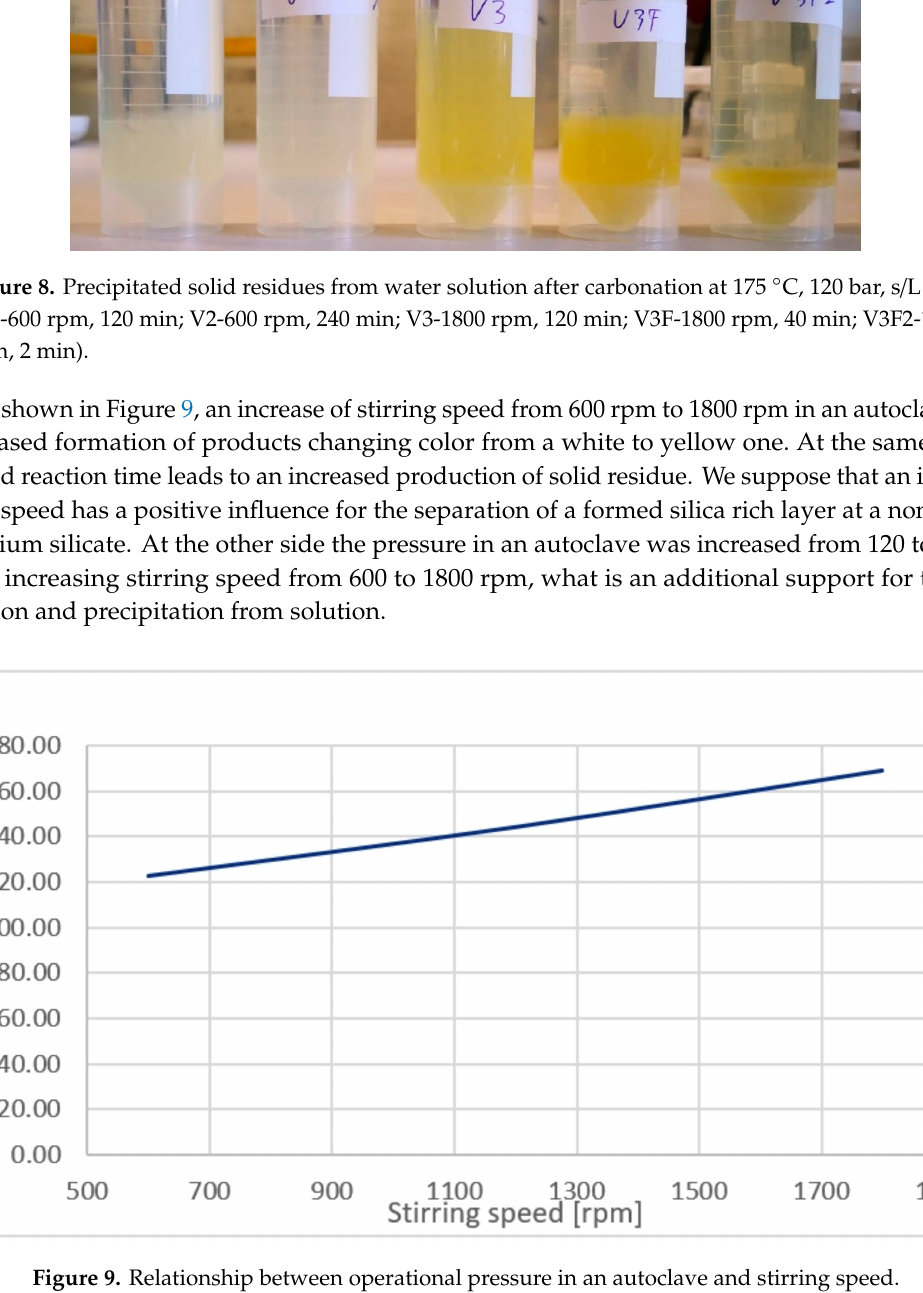
Figure 9. Relationship between operational pressure in an autoclave and stirring